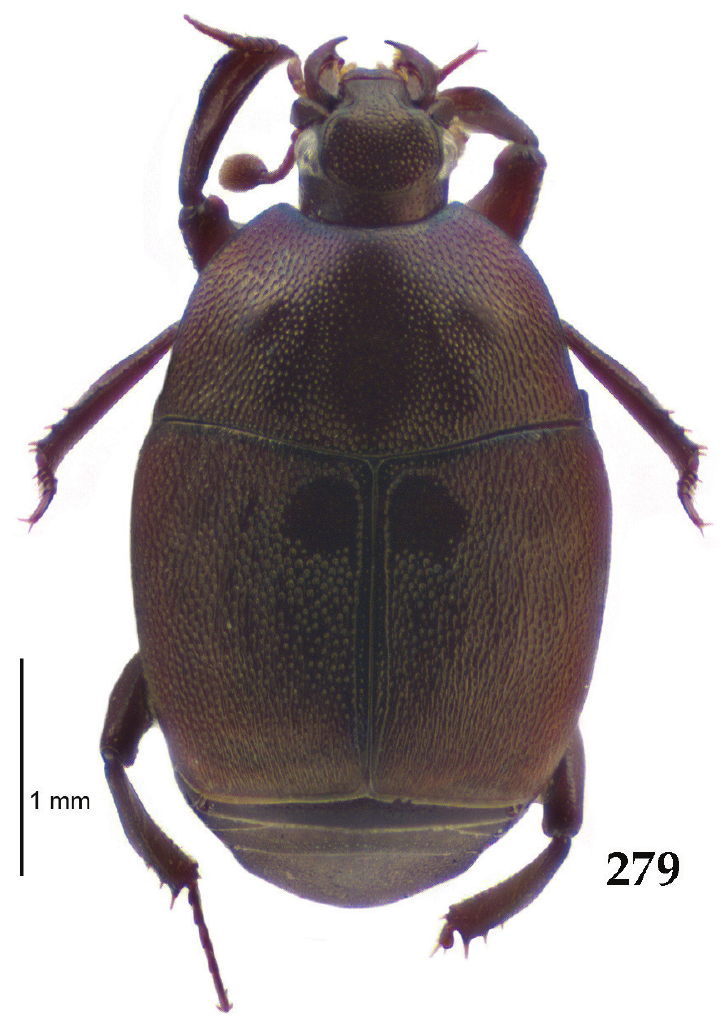
Figure 279. Saprinodes falcifer Lewis, 1891 habitus, dorsal view. Distribution. Endemic to Australia: New South Wales and Queensland (Fig. 759). Remarks. In this sexually dimorphic species the male has a large depression on the metaventrite and the first abdominal ventrite has coarser and larger punctures than that of the female. Females are also substantially larger than males. The minute setae associated with dorsal punctures observed by Dégallier (1993: 48) were not observed in our